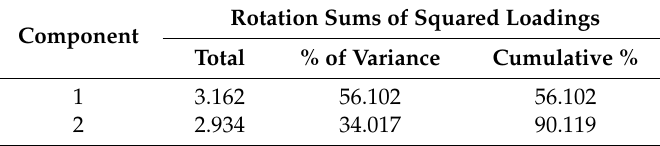
Table 1. Total variance explained.